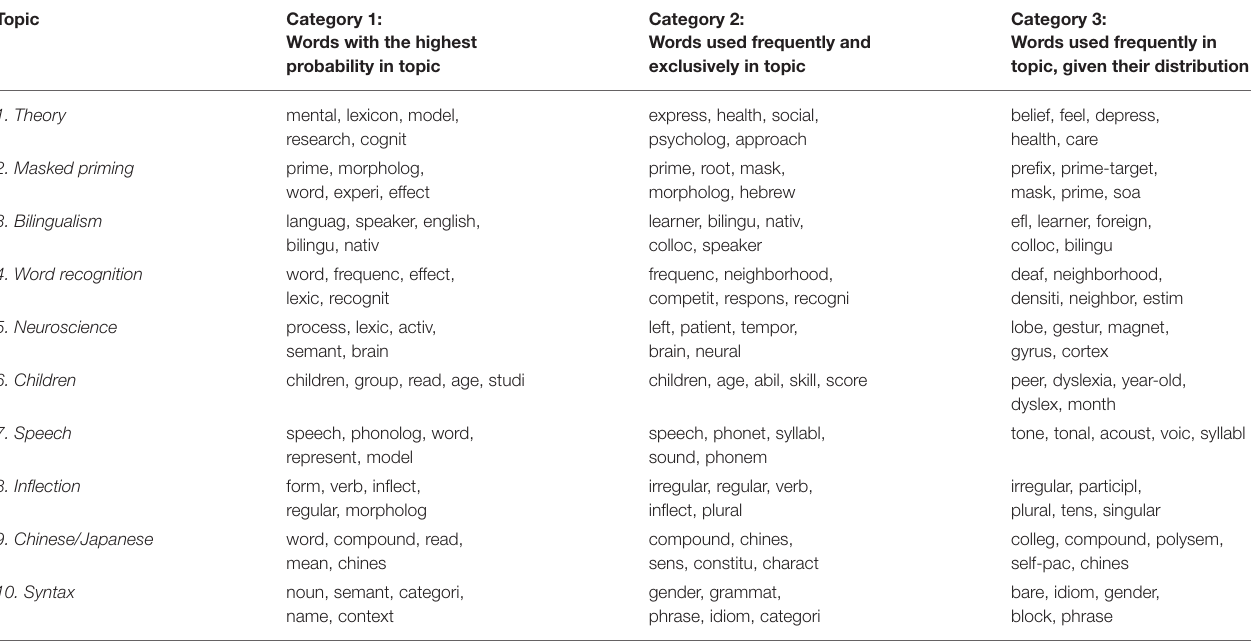
TABLE 1 | The Mental Lexicon topics represented as collections of most diagnostic words as reported in Kuperman et al.